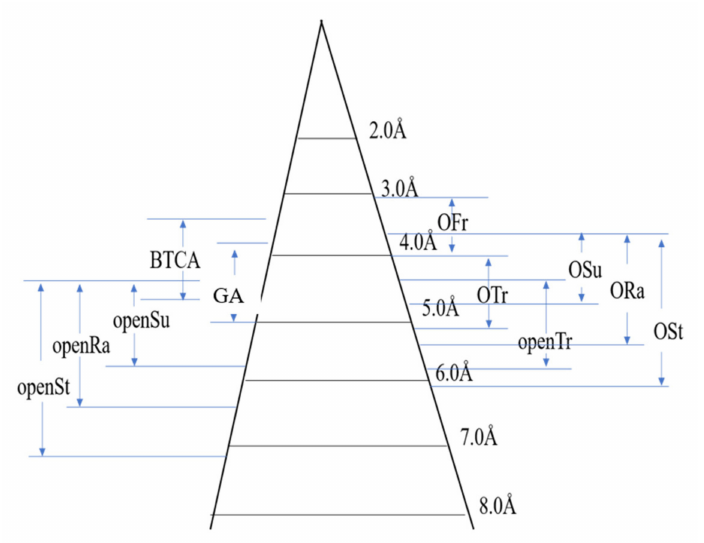
Figure 10. Effective crosslinking radius distribution of glycosyl anti-wrinkle finishing